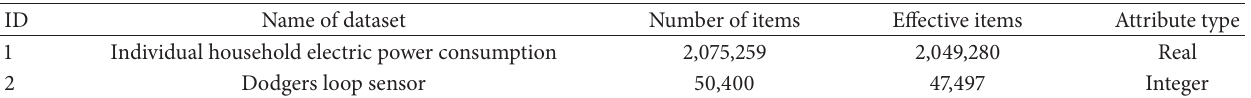
Table 1: Test UCI datasets.